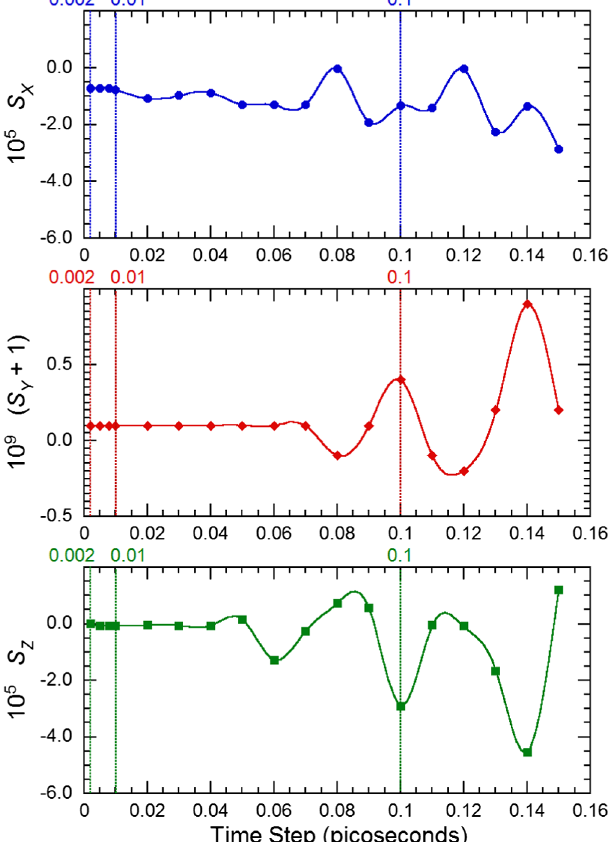
FIG. 2. Spin components at the exit of the snake as a function of time-step used for numerical calculations using Blewett-Chasman fields, for a 120 GeV = c beam entering the snake on-axis with ¼ 0 and S ¼ 1 TABLE II. Beam excursions and angles at the exit of the snake spin components S , S X Z Y Table I and Fig. 2 show the results for spin components at the exit of the snake for a 120 GeV = c beam entering the snake on-axis. One can see that for the vertical spin component ( S ) the results begin to converge for time steps Y below 0.07 picosec. The component S is most important, Y since it must be rotated by exactly 180° for a full snake. Table I and Fig. 2 show that we achieved S rotation by 180° Y with very high precision; note the expanded vertical scales in Fig. 2. Note that S remained totally unchanged over the Y time-step range from 0.07 to 0.002 picosec, while the radial ( S ) and longitudinal ( S ) spin components oscillate sig- X Z nificantly. Also note that the S vertical scale is 10 4 times Y smaller than the S and S scales. X Z Table II and Fig. 3 show the results for the beam excursions and angles at the exit of the snake for a 120 GeV = c beam entering the snake on-axis. One can see that the results converge at time-steps below 0.005 picosec. The values of the beam excursions and angles at the snake exit are below 1 μ m and 0 . 16 μ rad, respectively; this certainly indicates that the snake should look like a drift space to the rest of the ring.